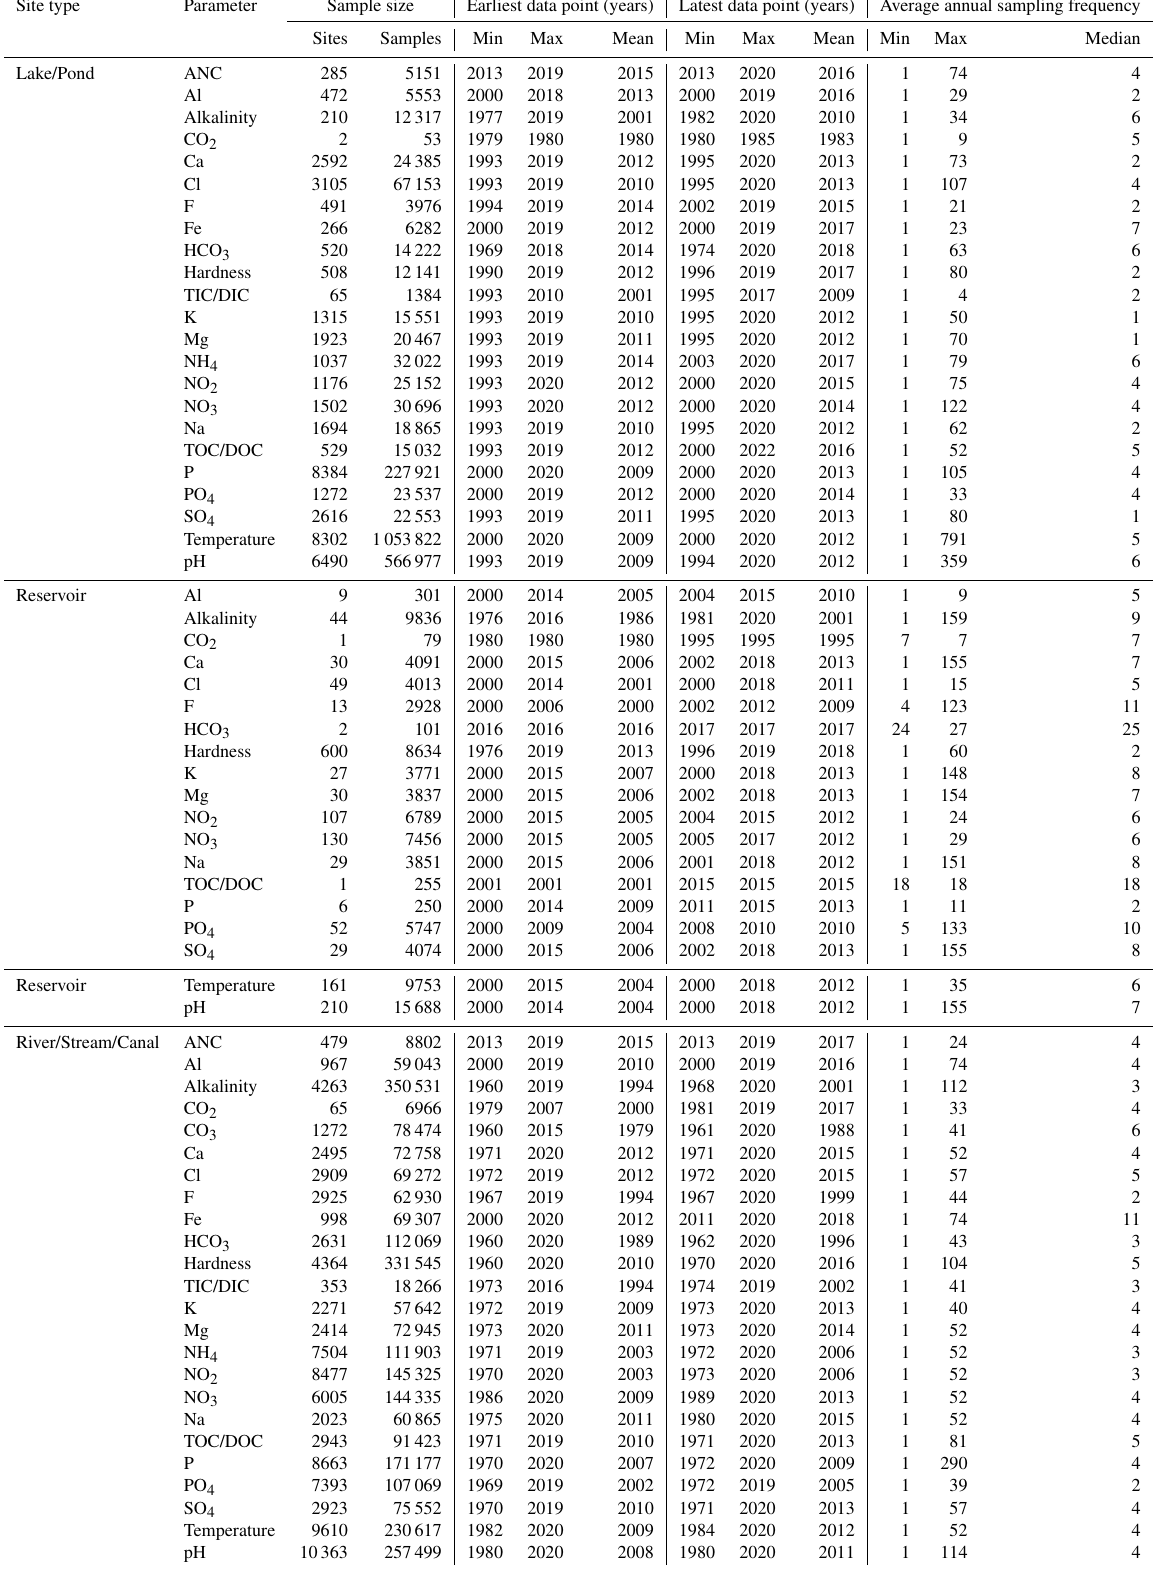
Table 2. Summary of sample size, time series start and end dates, and average annual sampling frequency throughout time series separated by waterbody type and variable. Minimum and maximum are abbreviated as Min and Max,